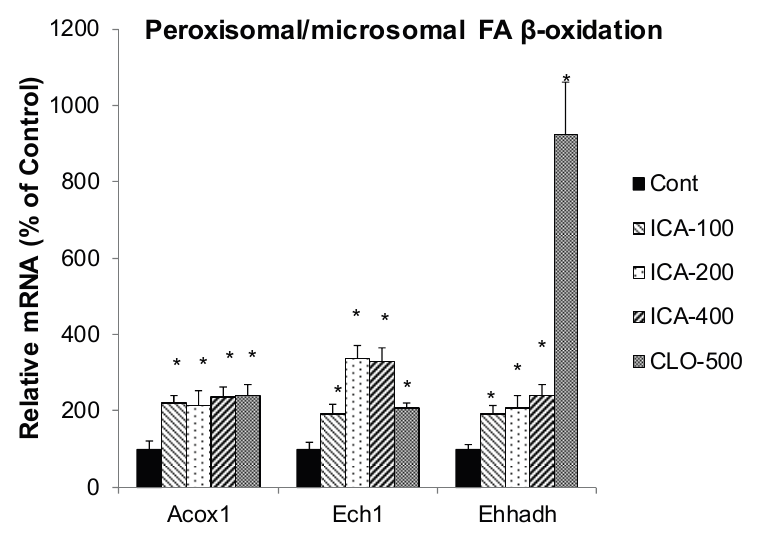
Figure 4. Effects of Icariin (ICA) on expression of peroxisome fatty acid β -oxidation enzymes. Data are expressed as mean ± SEM (n = 5). * Significantly different from CMC-treated mice ( p < 0.05).